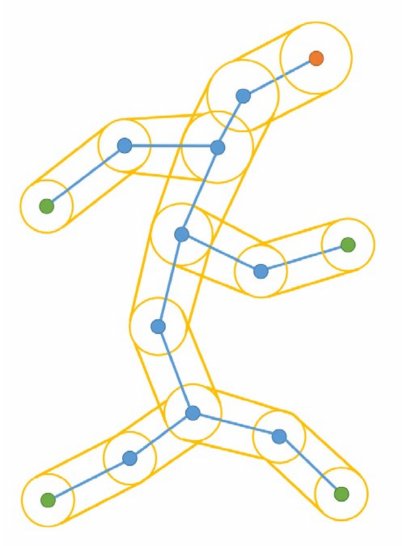
Figure 4. The a priori space expanded from the a priori